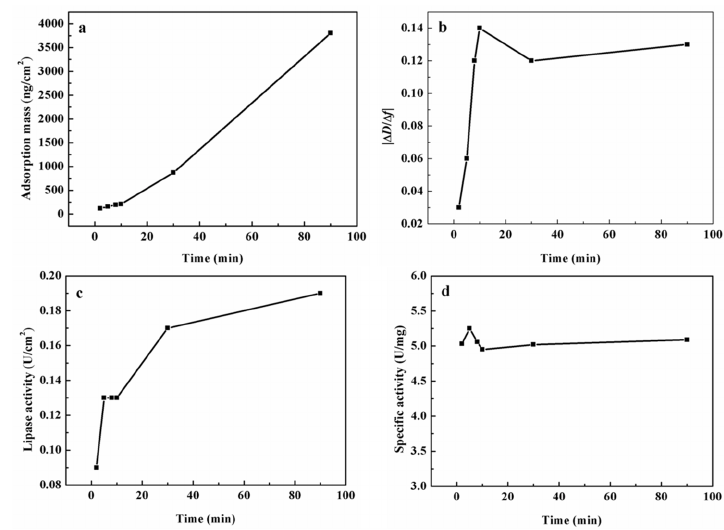
Figure 6. Adsorption of lipase on PST chip determined by QCM-D (( a ) Adsorption mass; ( b ) | Δ D / Δ f | ratio; ( c ) Lipase activity; ( d ) Specific activity). ratio; ( c ) Lipase activity; ( d ) Specific